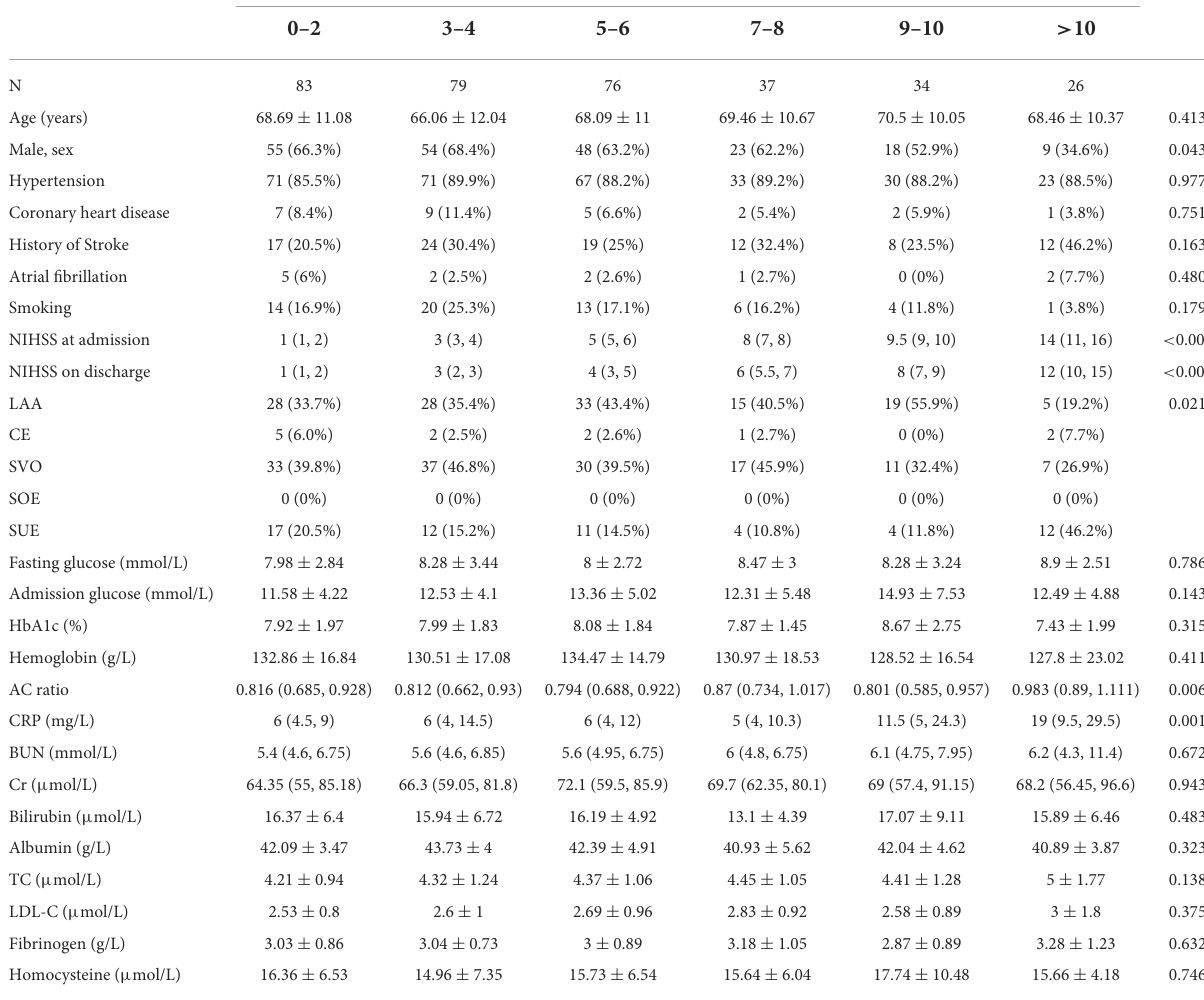
TABLE 1 Baseline characteristics of different groups separated according to admission